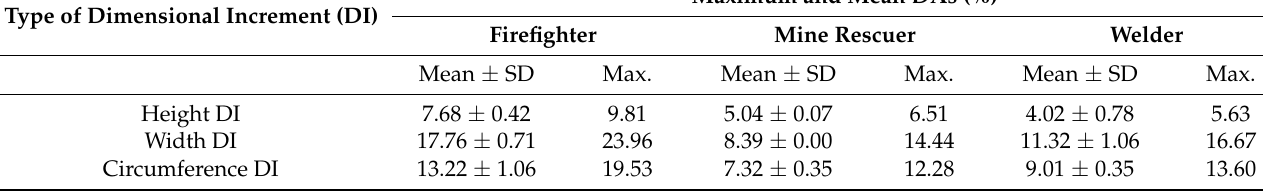
Table 4. Maximum and mean height, width, and circumference DAs with standard deviation (SD) for females (in the 5th, 50th, and 95th percentile groups) in firefighting, mine rescue, and welding PPE kits expressed in terms of percentage dimensional increments (DIs).